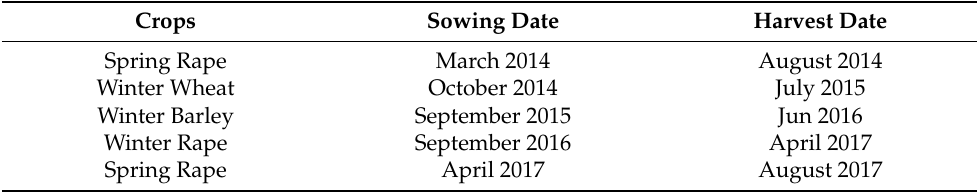
Table 2. Crop rotation date in the studied period in four studied plots.